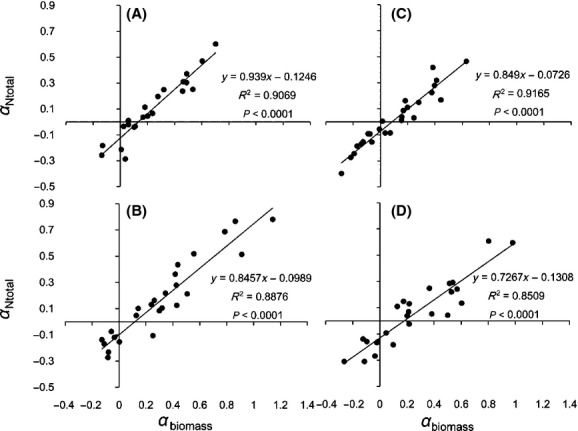
Relationship between αNtotal and αbiomass for Stipa under elevated CO2. S. baicalensis (A), S. bungeana (B), S. grandis (C), and S. breviflora (D).